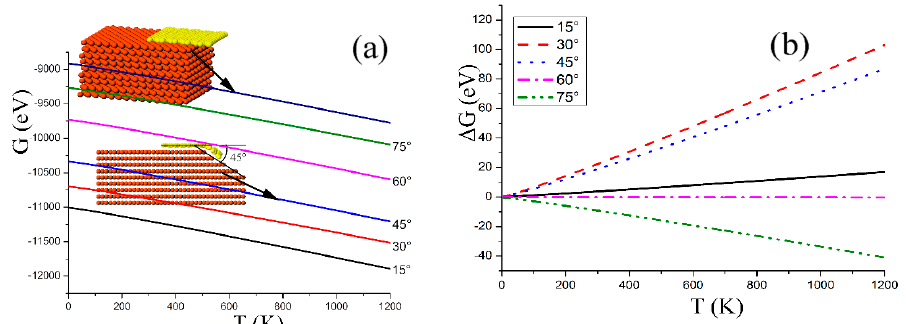
Figure 3. ( a ) The GFE of a piece of graphene sheet on boundaries of different slopes as a function of the temperature, and ( b ) the difference defined as G f − G b for a given slope.